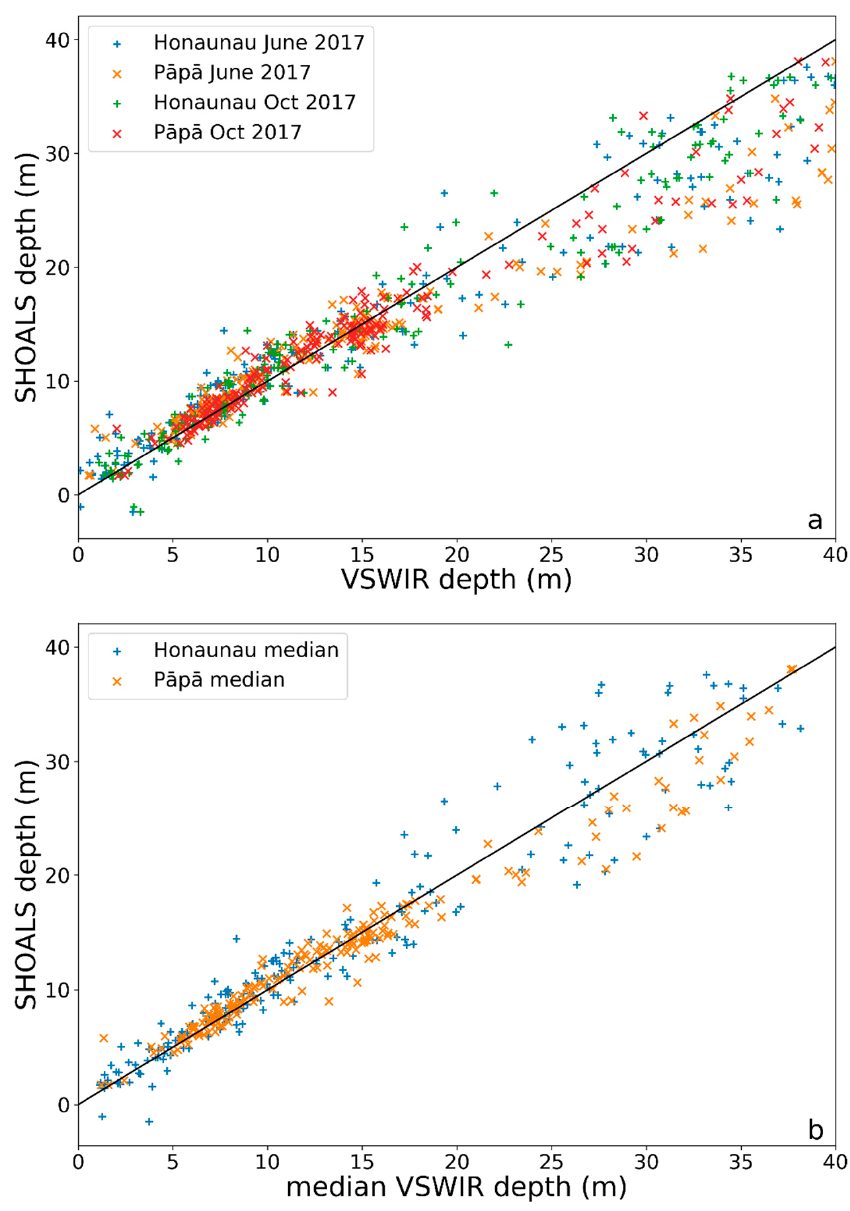
Figure 5. Scatterplot of SHOALS-derived seafloor depth measurements against the depth estimated from VSWIR imaging spectrometer measurements. ( a ) Estimates by individual date. ( b ) Median values for all dates at each site. The solid black line is the 1:1 line.